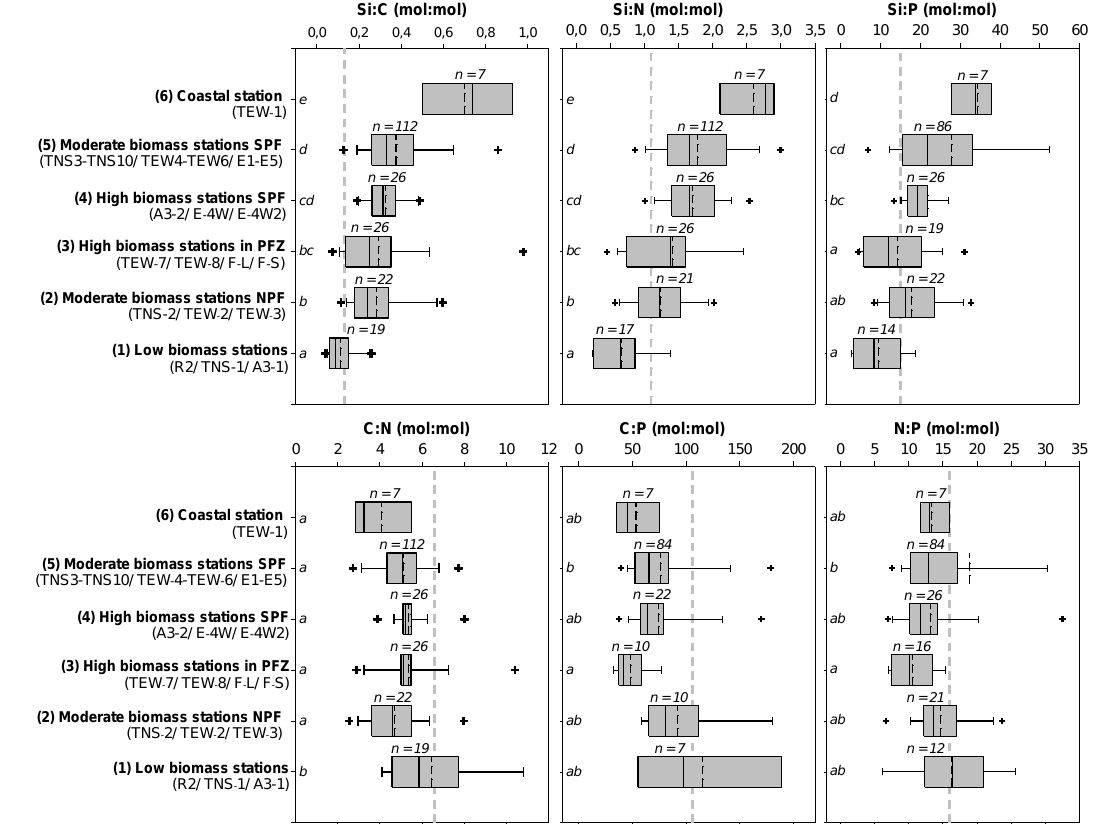
Figure 13. Box plots of the Si:C, Si:N, Si:P, C:N, C:P, and N:P molar ratios within 200m (except for TEW-1 and TEW-2 where data were restricted within 70m) for six clusters of stations located in the polar front zone (PFZ), north (NPF) and south of the polar front (SPF). Figure 13. The length of the box corresponds to the distance between the 5th and the 95th percentiles. The plain line and the dashed line inside the box represent the median and the mean respectively. The vertical lines extend to the minimum and maximum values of the cluster. The cross symbols correspond to outliers and “ n ” is the number of values in each cluster. The grey dashed lines represent the typical values of Si:C (0.13), Si:N (1.1) and Si:P (15) for nutrient-replete diatoms reported by Brzezinski (1985) and the typical values of C:N (6.6), C:P (106), and N:P (16) reported by Redfield et al. (1963). The clusters of which medians are not statistically different are indicated by the same letter (Mann–Whitney u test, p